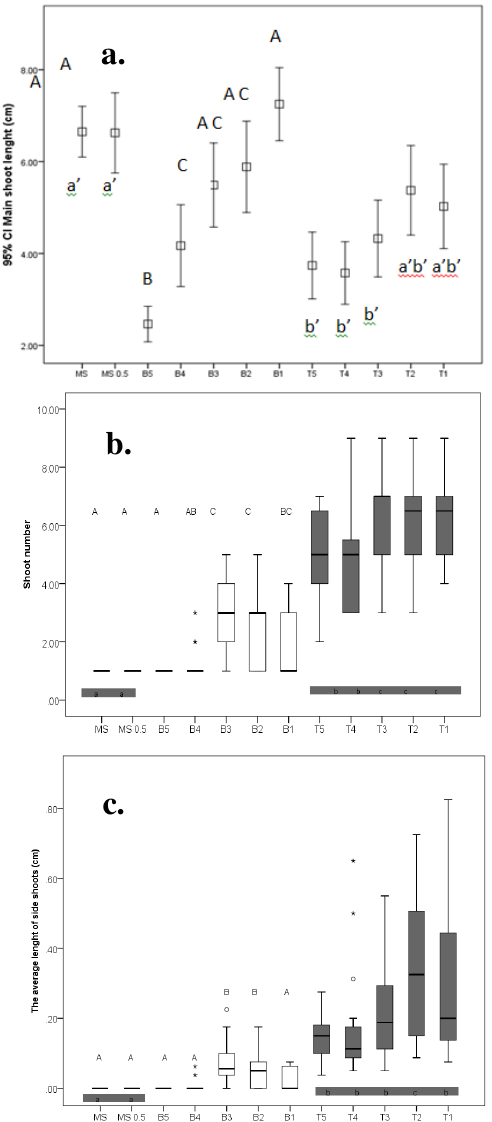
Fig. 2. Main shoot length ( a ); N